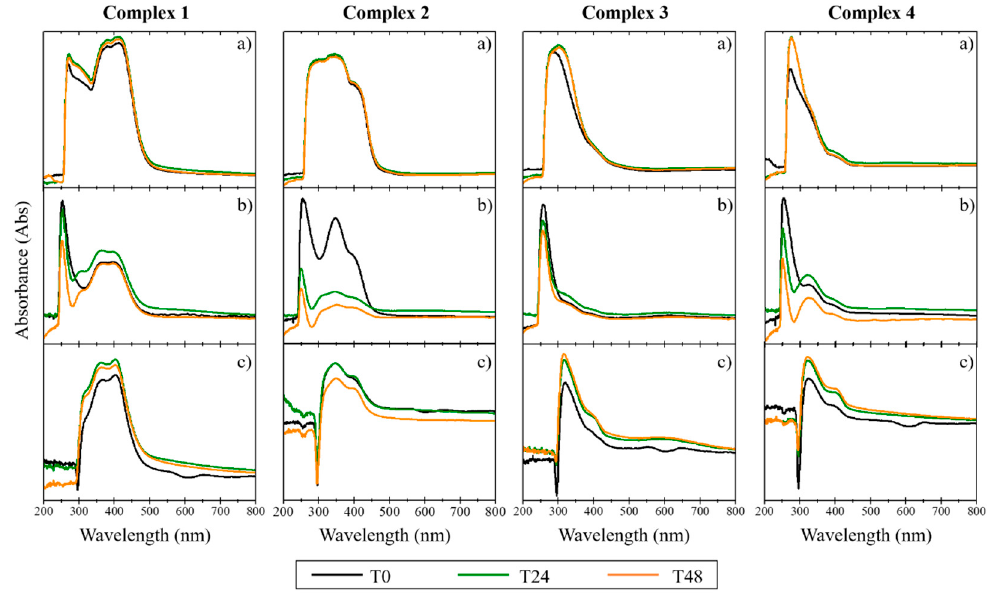
Figure 2. UV/Vis spectra of copper complexes ( 1 , 2 , 3 and 4 ) in DMSO solution ( a ), and in phenol red-free DMEM in the absence ( b ) and presence of FBS ( c ). The data were collected at T = 0 h (T0), T = 24 h (T24), and T = 48 h (T48) after creating the complex solutions.